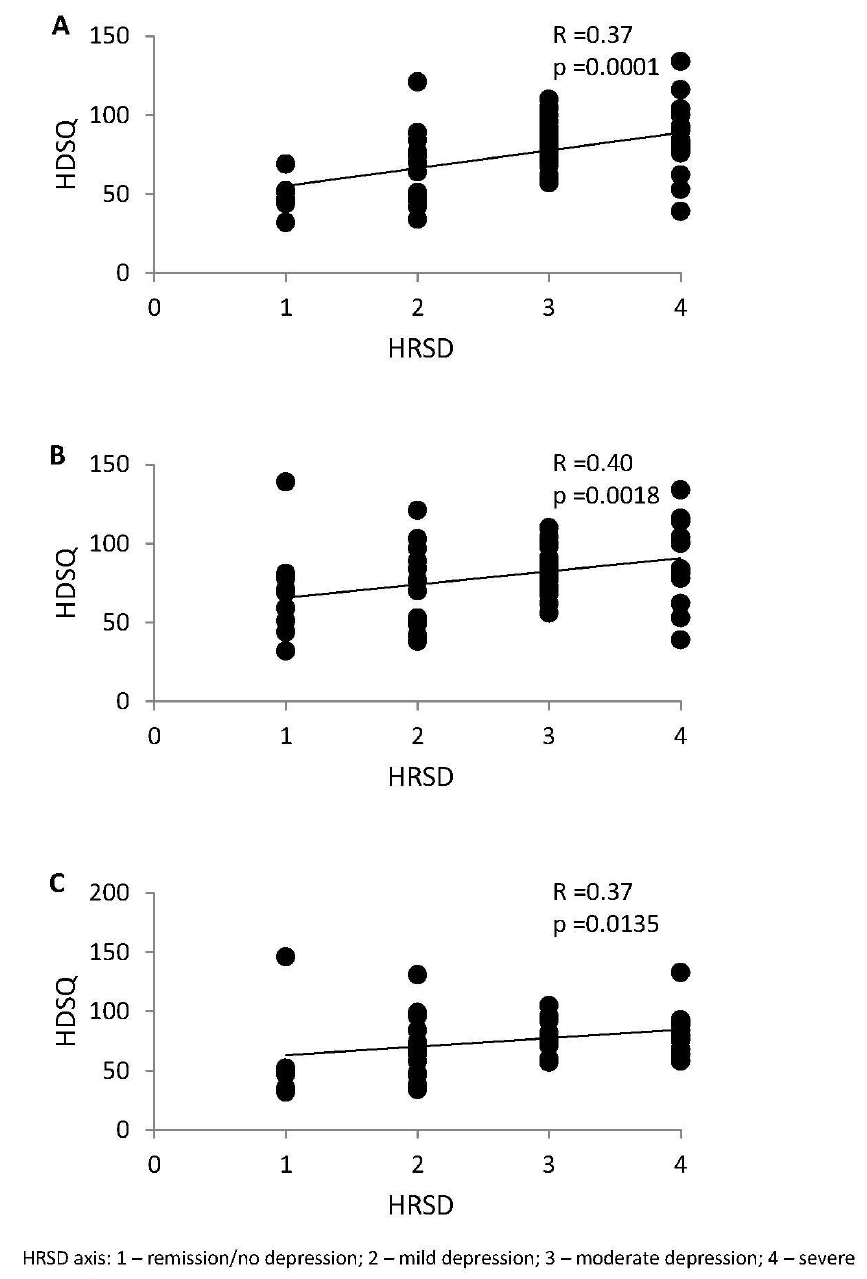
Figure 1. Correlations of depression severity based on HRSD (score in categories) and sleep quality based on HSDQ in the study groups. ( A ) All, ( B ) women, ( C ) men. Of the 37 patients with UI, 35 patients complained of at least moderate LUTS as assessed with the IPSS. This patient subgroup reported mostly the frequency (question #2 from the IPSS, mean score: 2.74 ± 1.65), urgency (question #4 from the IPSS, mean score: 2.25 ± 1.68), and occurrence of nocturia (question #7 from the IPSS, mean score: 2.97 ± 1.74). Patients also reported, with lower severity, incomplete emptying (question #1 from the IPSS, mean score: 1.05 ± 1.39), intermittency (question #3 from the IPSS, mean score: 1.31 ± 1.56), weak stream (question #5 from the IPSS, mean score: 1.25 ± 1.42), and straining (question #6 from the IPSS, mean score: 0.82 ±